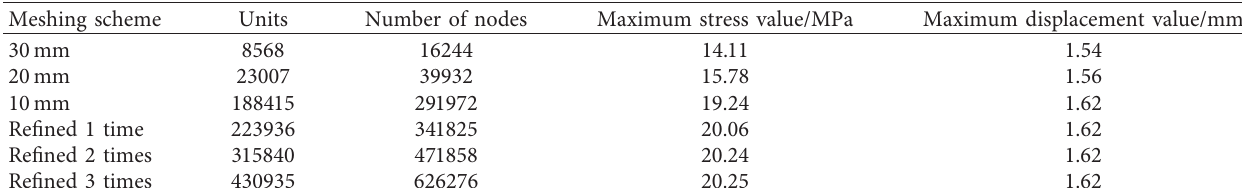
Figure 6: Mesh division: (a) guide vane section; (b) runner section. Table 4: Grid division of solid computing domain.